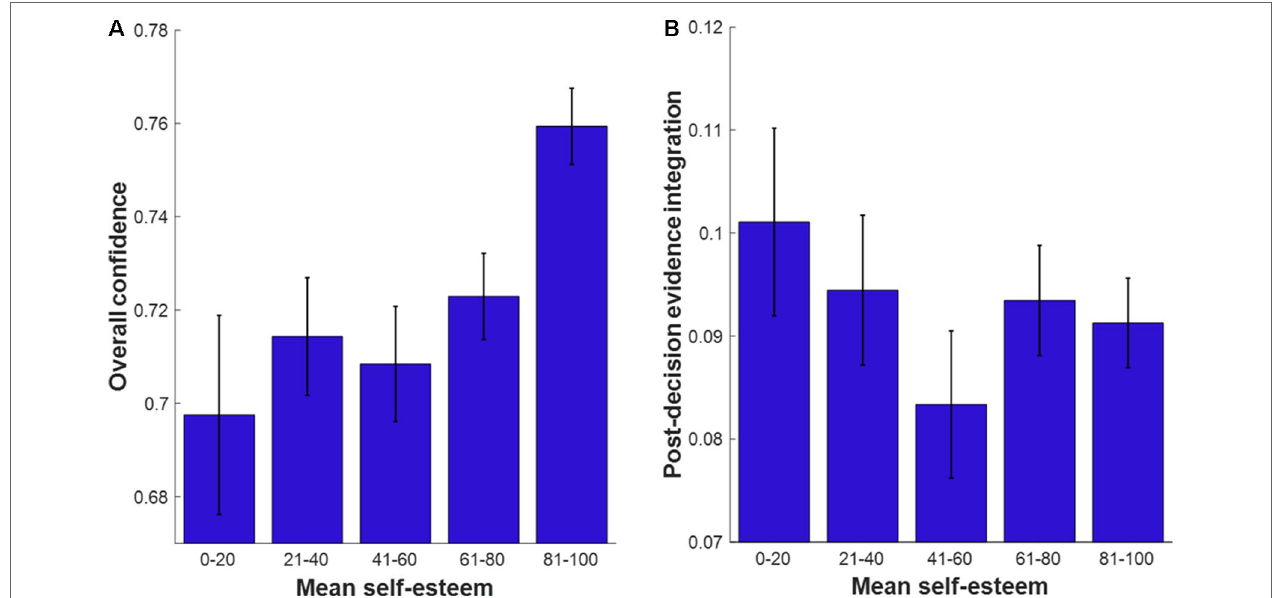
FIGURE 6 | Metacognitive variables as a function of self-esteem score in five bins. Error bars indicate the standard errors of the mean. (A) Mean overall confidence plotted as a function of self-esteem bins. (B) Mean postdecision evidence integration plotted as a function of self-esteem bins. Ns per bin: Self-esteem score 0–20 (n = 44), 21–40 (n = 59), 41–60 (n = 51), 61–80 (n = 111), 81–100 (n =